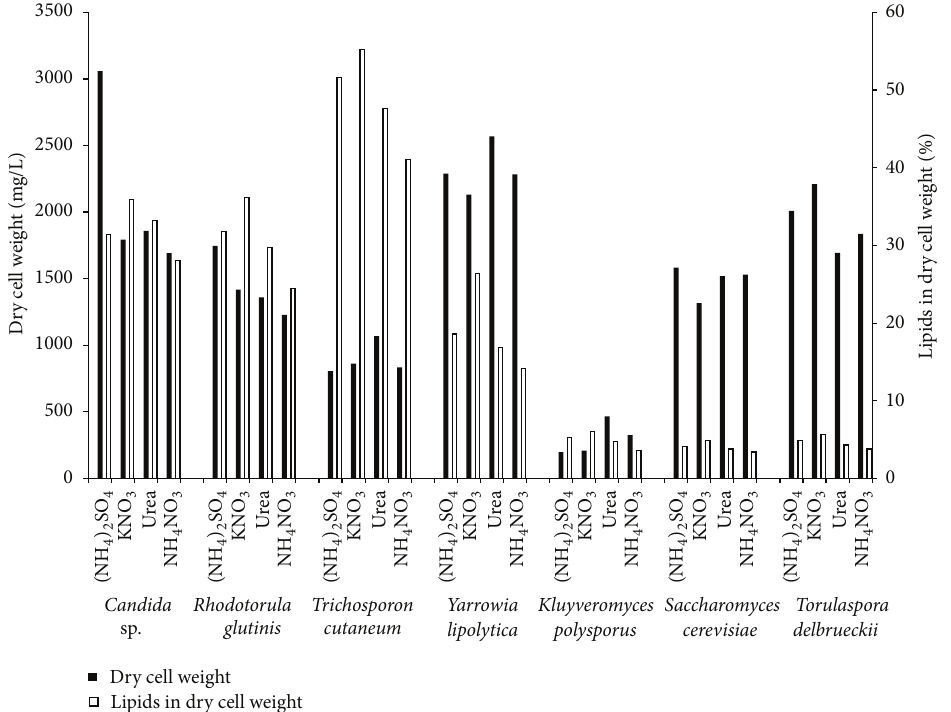
Figure 1: Biomass yield (black bars, dry cell weight) and lipid content in dry cell weight (white bars) of the 7 yeast strains cultured on 4 nitrogen sources at C/N ratio 70.